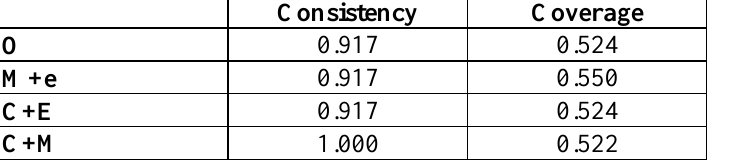
Table A3.3. Results of the csQCA for the analysis of necessity for the group success. L=Leader, K=Knowledge generator, C=Connector, F=Follower, M=Moralist, E=Enforcer, O=Observer.